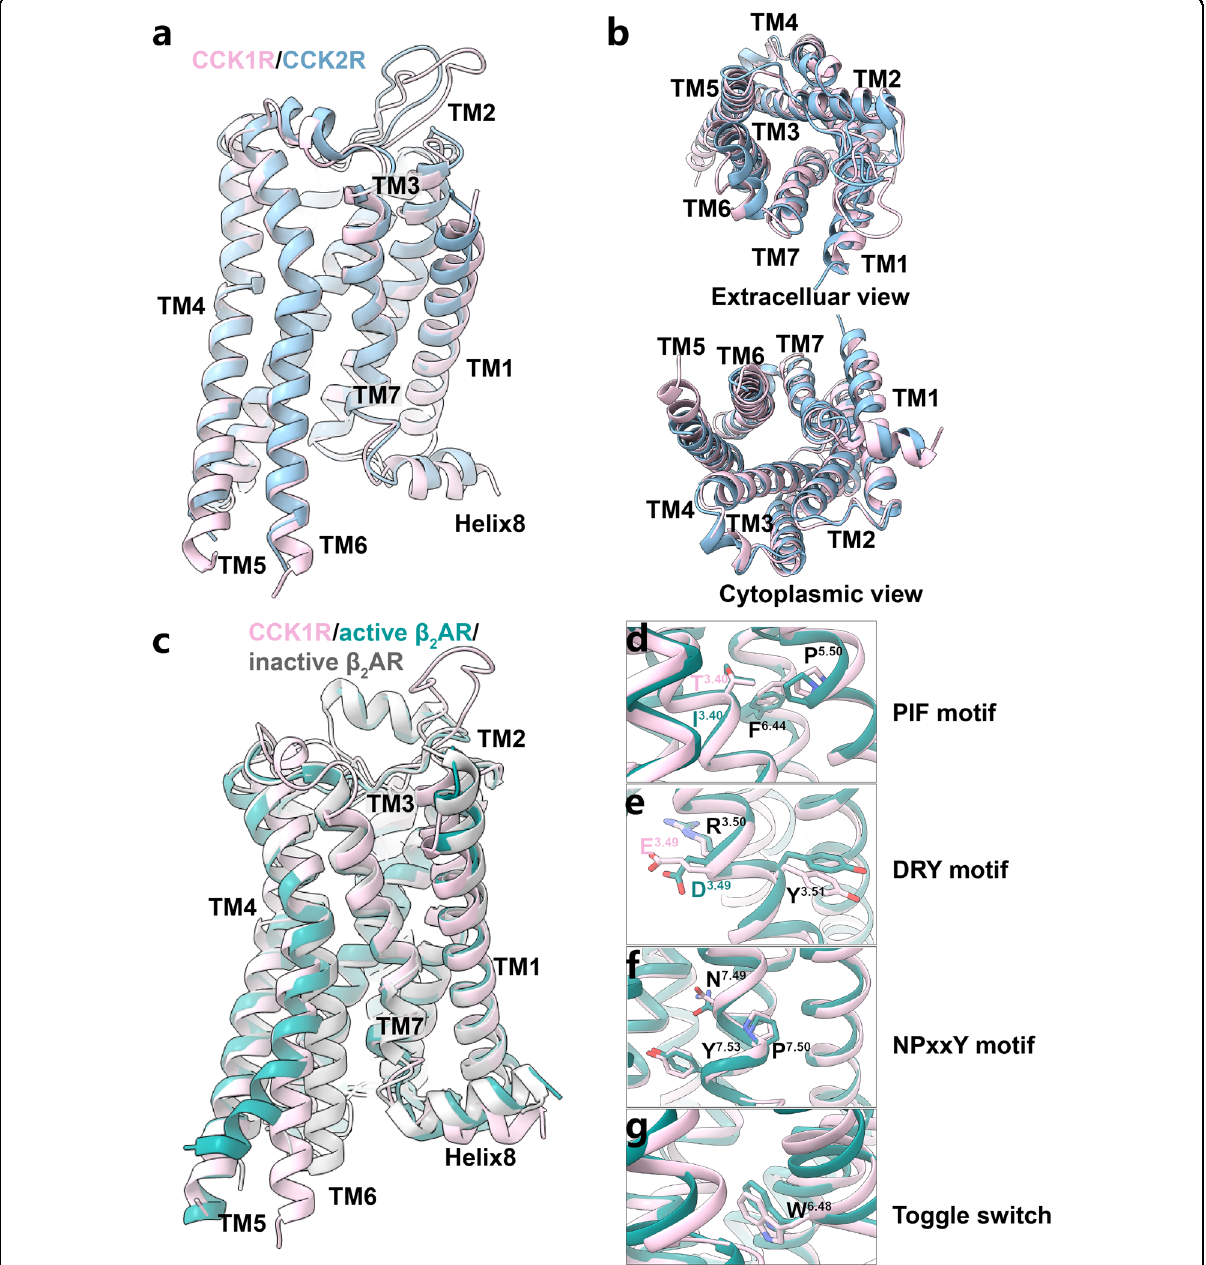
Fig. 5 Structural comparisons between CCK1R, CCK2R, and other activated class-A GPCRs. a , b Superposition of SR146131-activated CCK1R (pink) with CCK-8-bound CCK2R (blue). Side view ( a ). Extracellular and cytoplasmic views ( b ). c Superposition of SR146131-activated CCK1R (pink) with active β 2 AR (dark green) and inactive β 2 AR (gray). d – g Close-up views of conformational changes in crucial residues involved in CCK1R (pink) and β 2 AR (dark green)